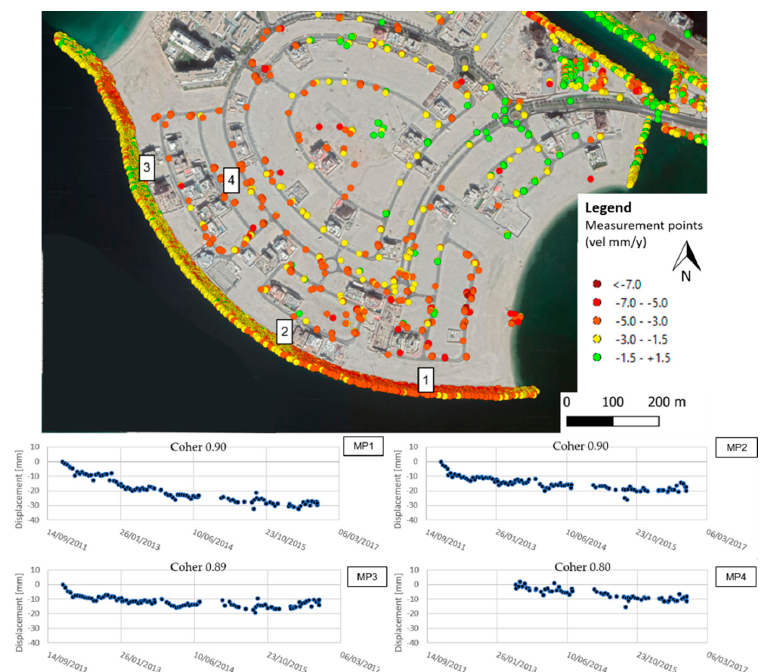
Figure 12 . Advanced Differential Synthetic Aperture Radar Interferometry (A-DInSAR) results, including the average settlement velocity map (in mm/year) and time series of displacement (in millimeters). The color of MPs shows the intensity and values of displacement. Specifically, green points are considered stable (average Line Of Sight (LOS) velocity between 1.5 and − 1.5 millimeters per year); while yellow to red color is referred to a movement away from the satellite sensor (i.e., in this specific case, settlements). Time series of displacement of 4 areas located on the revetment and over a structure on the sand fill is reported. Point 4 represents a Temporary MP that became stable in February 2013. Project carried out using COSMO-SkyMed ® PRODUCTS, © ASI (Italian Space Agency)—provided under license of ASI.